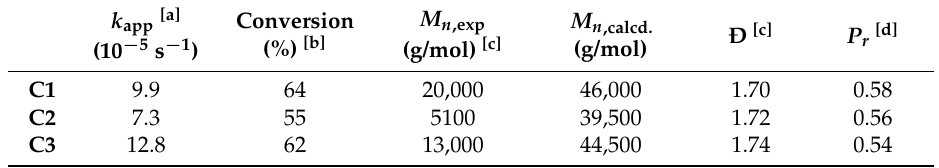
Table 5. Polymerization data from polymerization method a for complexes C1 – C3 after two hours.